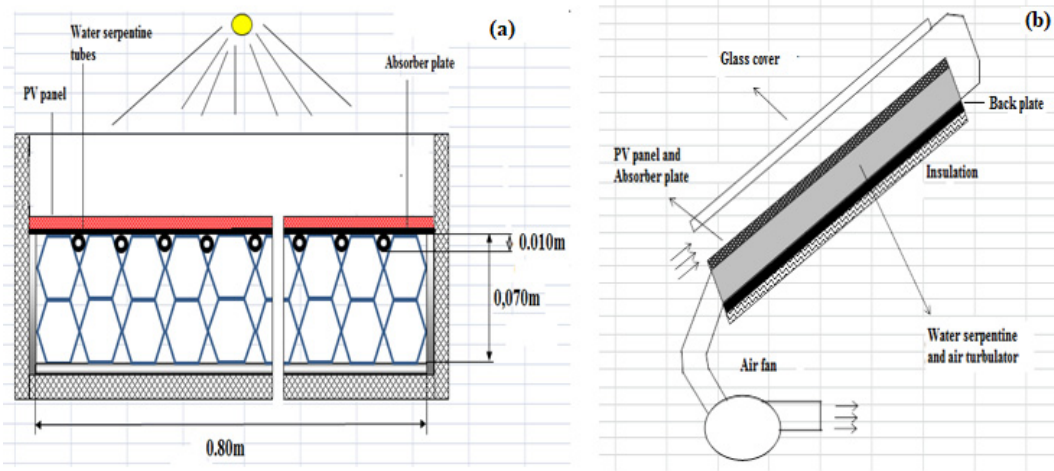
Figure 2. Details of module-3 [21] ( a )cooling unit of module-3 ( b ) cross-section of module-3. Processes 2019 , 7 , x FOR PEER REVIEW